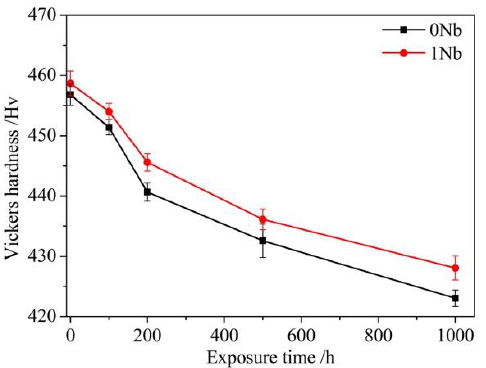
Figure 3. Vickers hardness of the 0Nb and 1Nb alloys during long-term exposure at 800 °C up to 1000 h.